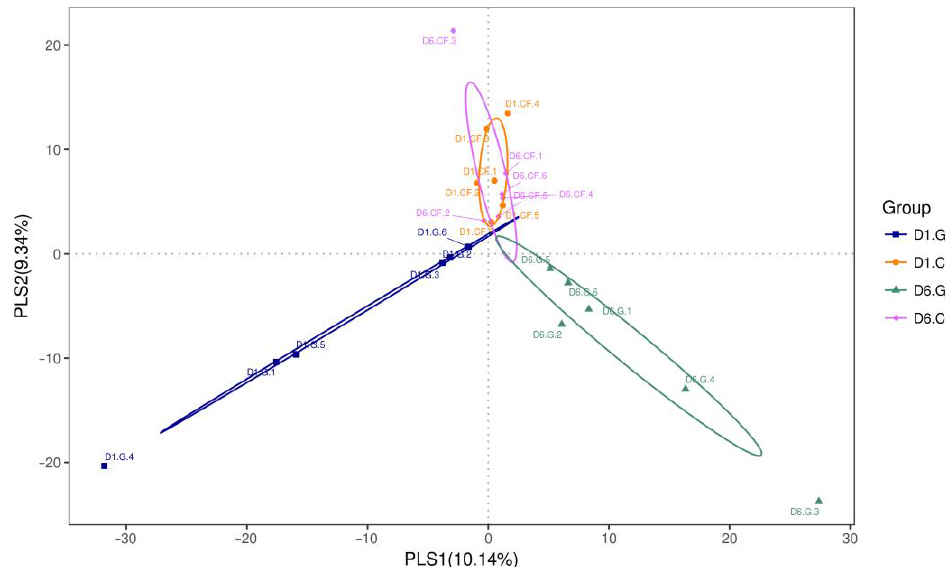
Figure 8. Partial least squares discriminant analysis (PLS-DA) of bacteria identified in wound-contact chitosan and regular gauze dressings for up to 6 d post-surgery. PLS1 and PLS2 represent 10.14% and 9.34% of variance, respectively. (D1 = day 1; D6 = day 6; G = gauze; CF = chitosan).